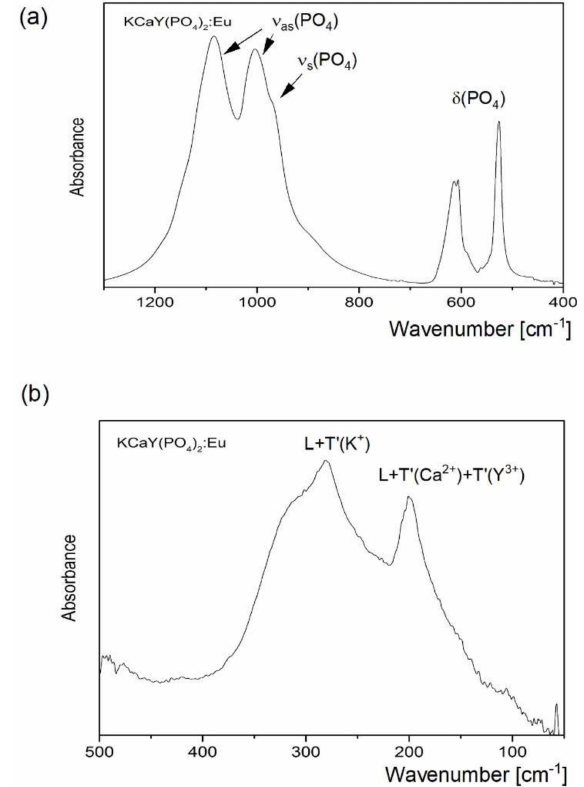
Figure 6. Infrared absorption spectra of KCaY(PO 4 ) 2 :Eu 3+ in the ( a ) FIR and ( b ) MIR range. Position of the stretching ( ν ) and bending ( δ ) modes as well as libration and translation are marked in the figures.